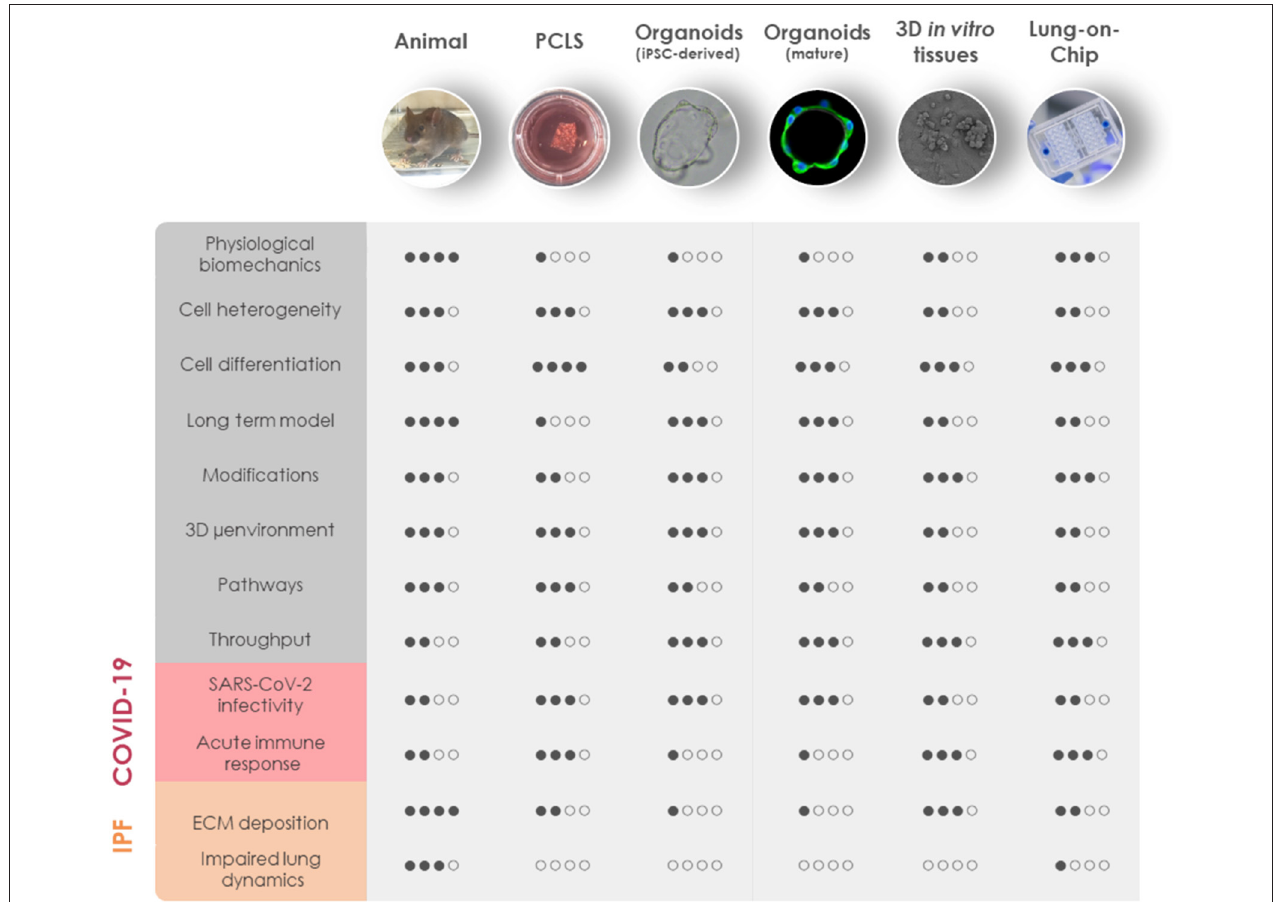
FIGURE 2 | Comparison of in vivo and 3D in vitro lung models for COVID-19 and fibrosis research. General aspects of experimental animal models and advanced in vitro models including PCLS, iPSC-derived organoids, mature organoids, 3D in vitro tissues, and LOC are rated based on similarities to human physiology (physiological biomechanics, cell heterogeneity, cell differentiation, long-term model, and 3D microenvironment), genetic manipulation (modifications), the possibility for mechanistic investigations (pathways), and throughput capabilities (throughput). Their applicability to model the diseased state of the lung has been evaluated separately for COVID-19 and IPF. COVID-19, coronavirus disease 2019; IPF, idiopathic pulmonary fibrosis; iPSC, induced pluripotent stem cells; LOC, lung-on-chip; µ environment, microenvironment; PCLS, precision-cut lung slices; SARS-CoV-2, severe acute respiratory syndrome coronavirus